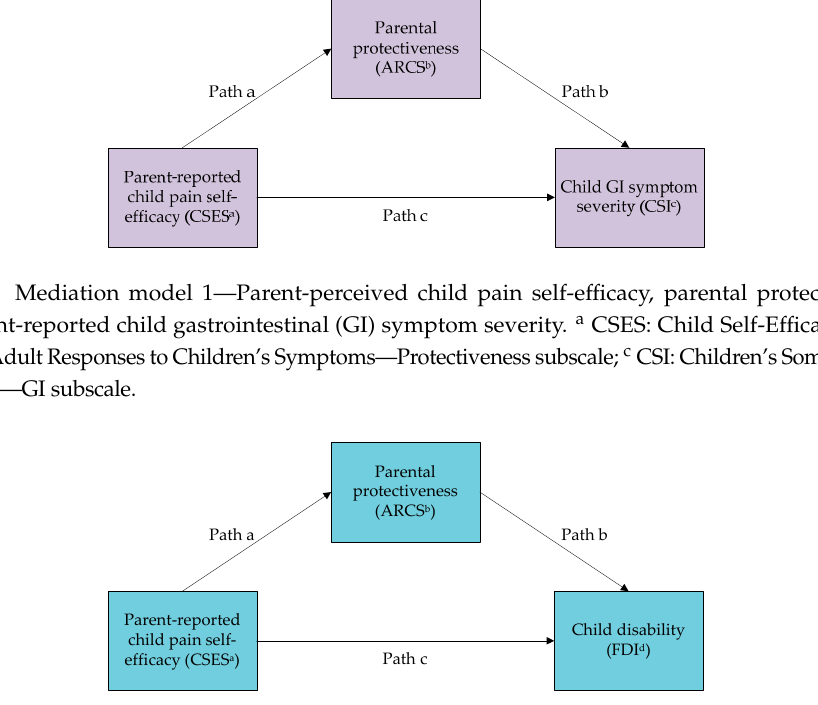
Figure 2. Mediation model 2—Parent ‐ perceived child pain self ‐ efficacy, parental protectiveness, and parent ‐ reported child disability. a CSES: Child Self ‐ Efficacy Scale; b ARCS: Adult Responses to Children’s Symptoms—Protectiveness subscale; d FDI: Functional Disability Inventory.